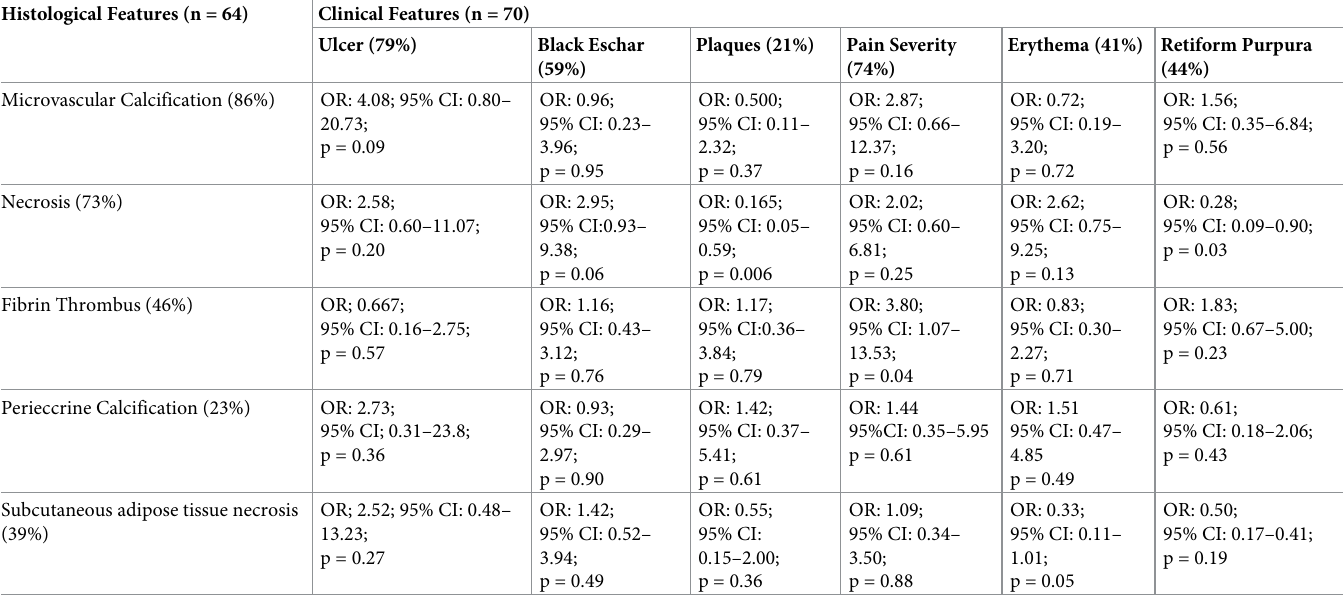
a . Odds ratio (OR), 95% confidence intervals (CI), and p values are reported from the examination of association between an individual clinical feature with an individual histological